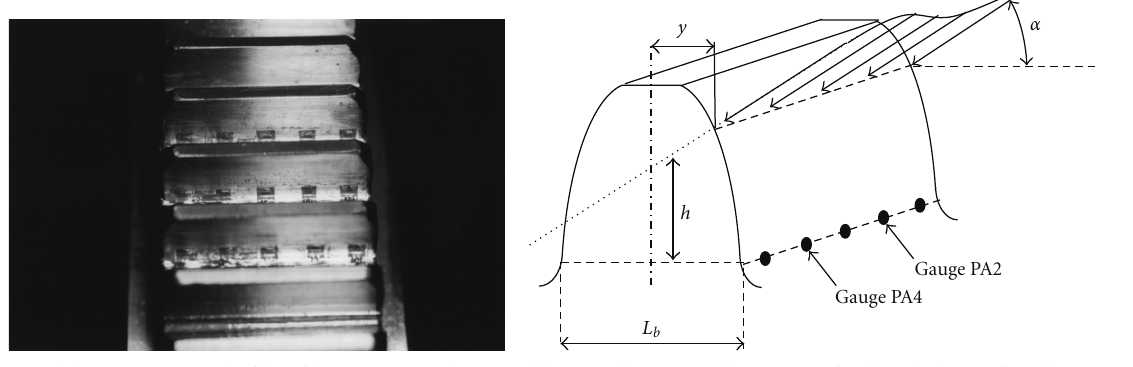
Figure 3: Gauges at the roots of the teeth.